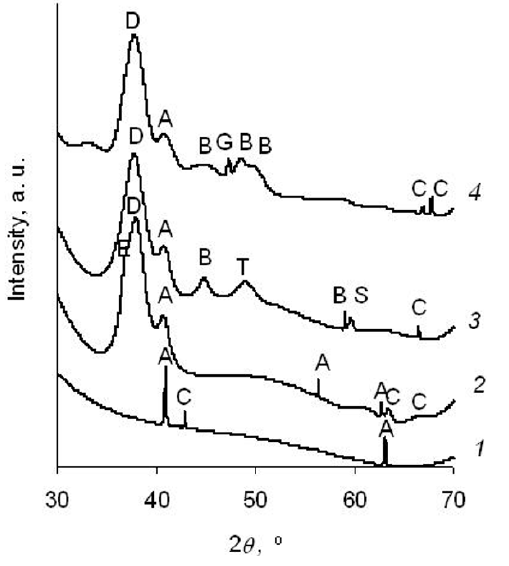
Figure 16. X-ray diffraction patterns (A – anilite, Cu